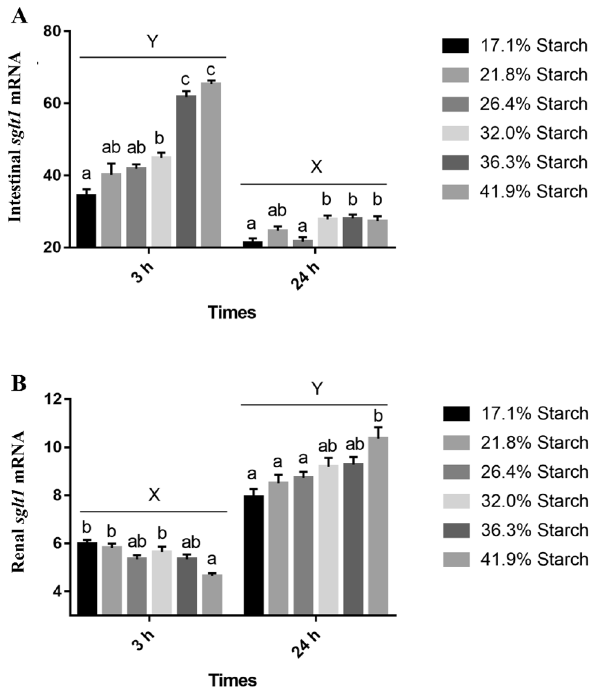
Figure 7. Relative expression of sglt1 in intestine and kidney in response to different starch levels at 3 h and 24 h after feeding. Vertical bars represent mean ± SE values. Value with the lowercase of different superscripts are significantly different, X and Y represent significant differences at 3 h and 24 h ( P <